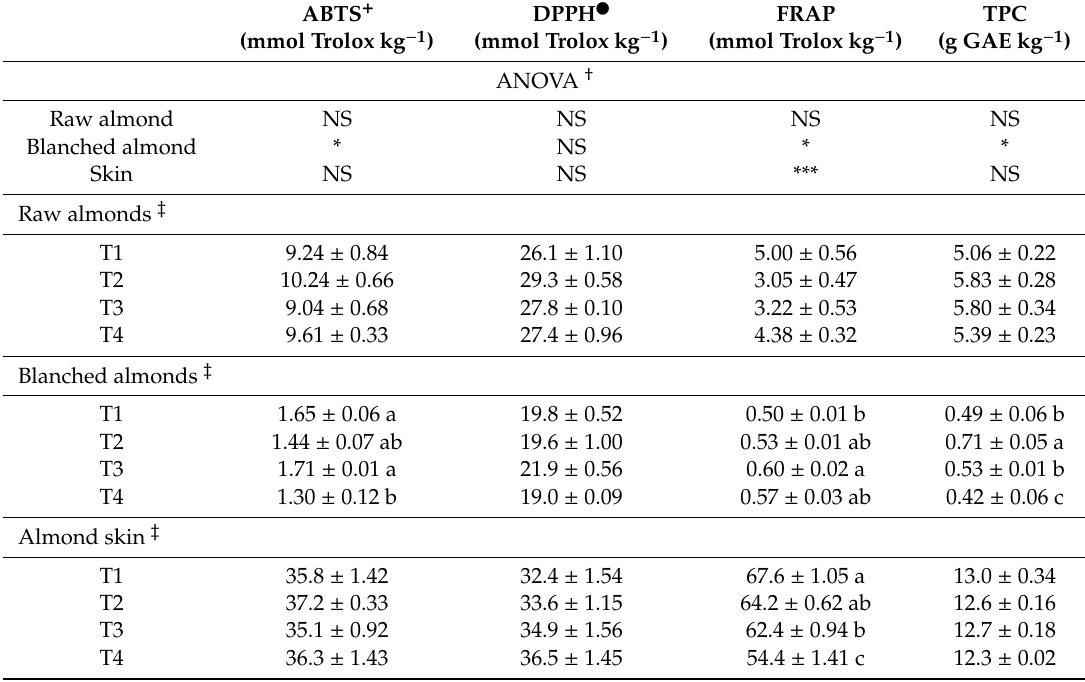
Table 2. Antioxidant activity (mmol Trolox kg − 1 ) and total phenolic content (mg gallic acid equivalents, GAE kg − 1 ) of almond, as a ff ected by deficit irrigation